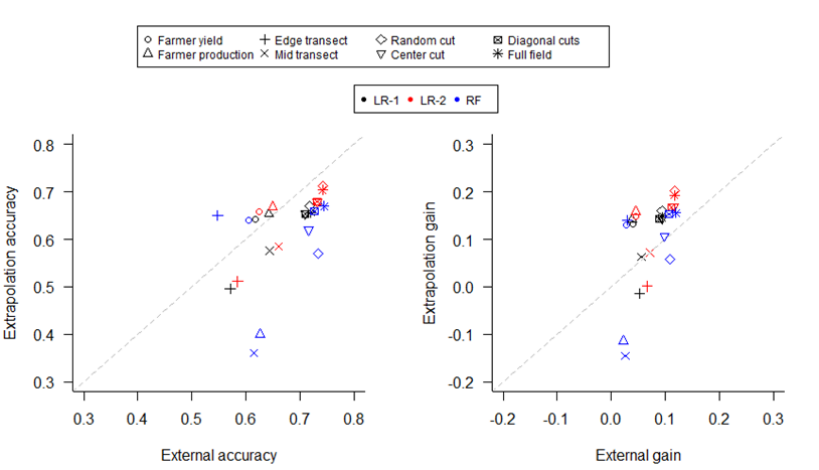
Figure 3. External accuracy vs. extrapolation accuracy and external gain vs. extrapolation gain for the yield prediction model that performed best in terms of external accuracy, for models based on data from eight field data collection methods (symbols) and three algorithms